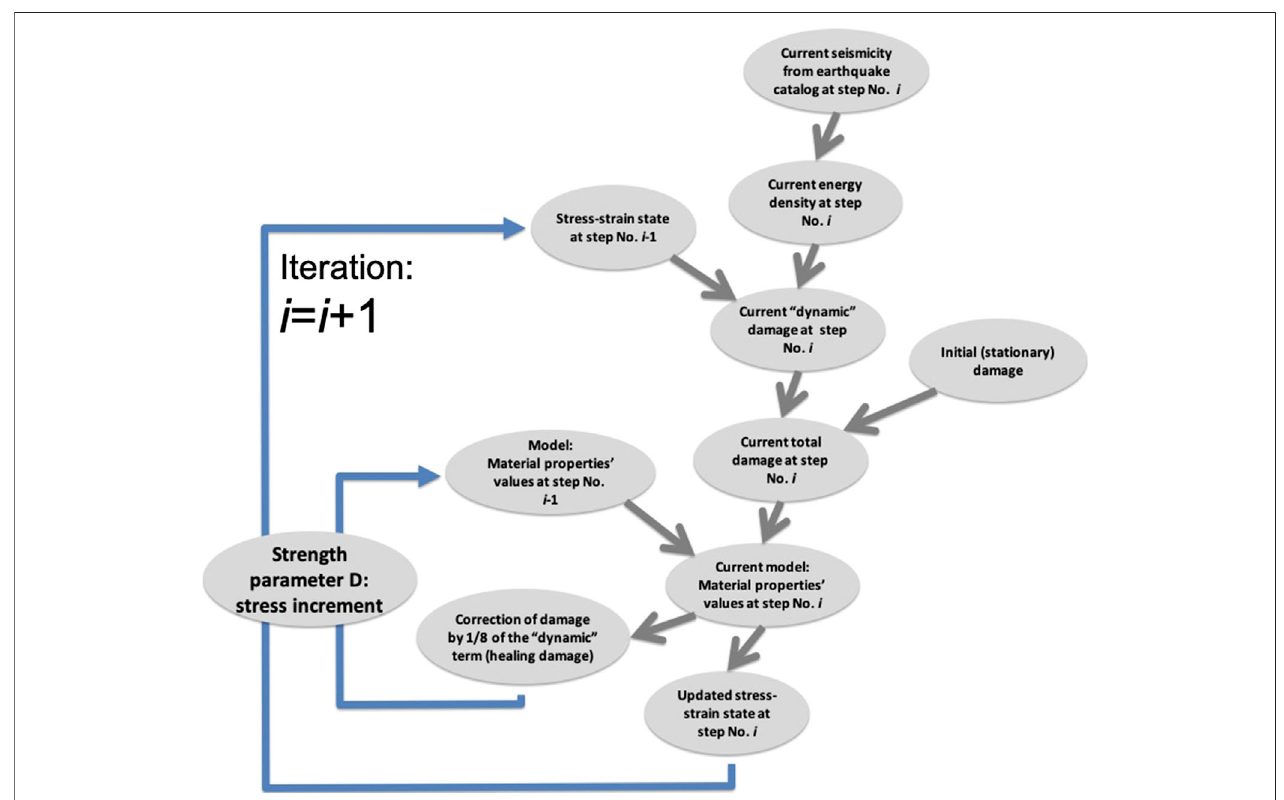
FIGURE 6 | Stress – strain state simulation cycle and strength parameter